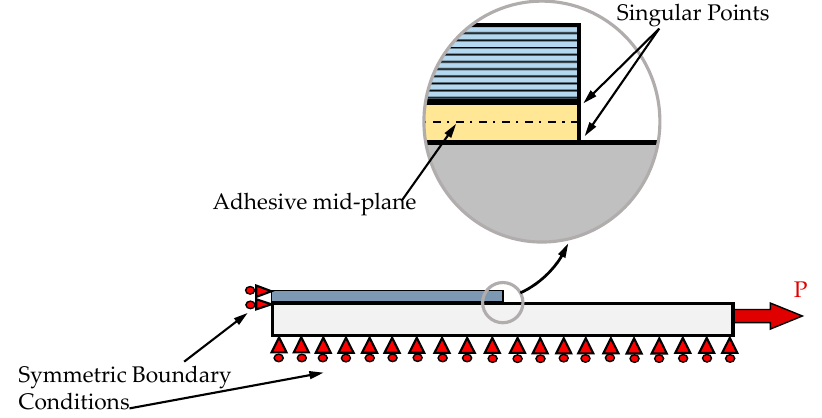
Figure 4. The applied boundary and loading conditions to the finite element model. ( P : applied load)